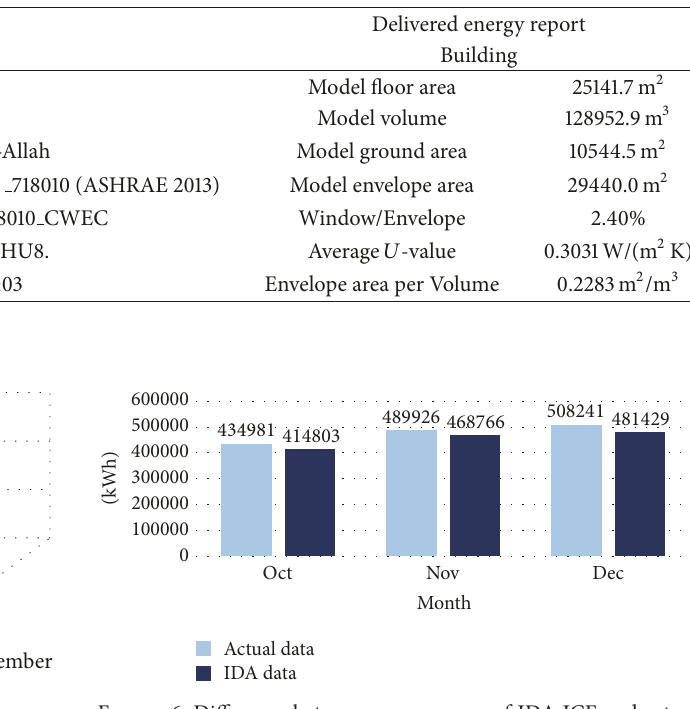
Figure 6: Difference between power usage of IDA ICE and actual data.